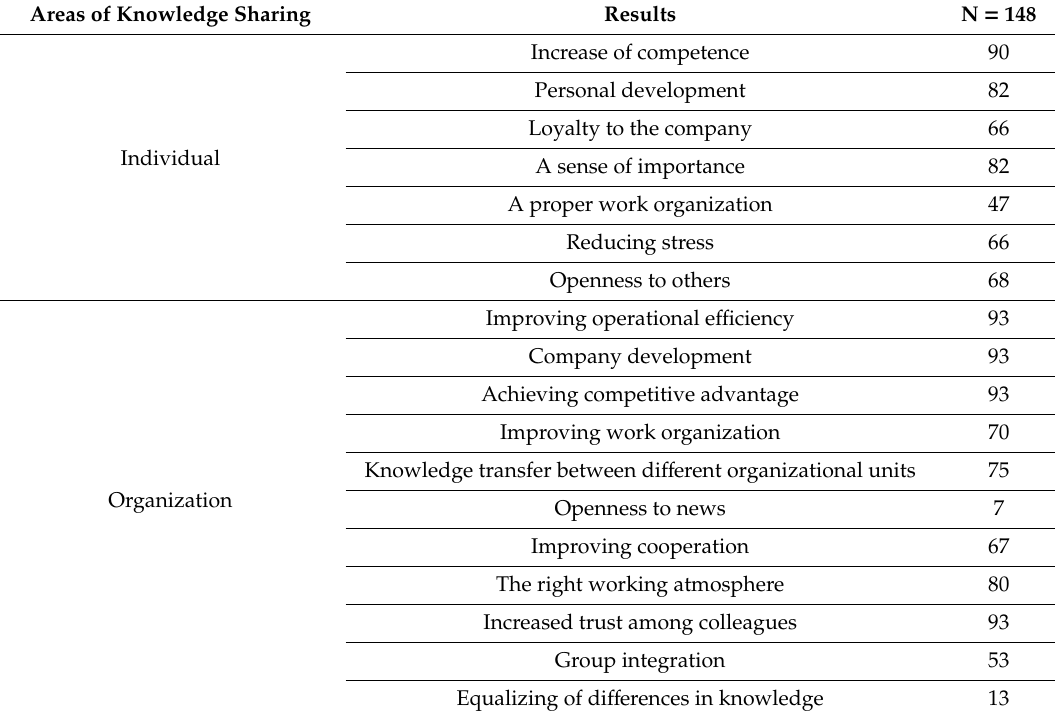
Table 2. E ff ects of knowledge sharing at the individual and organization level (%).